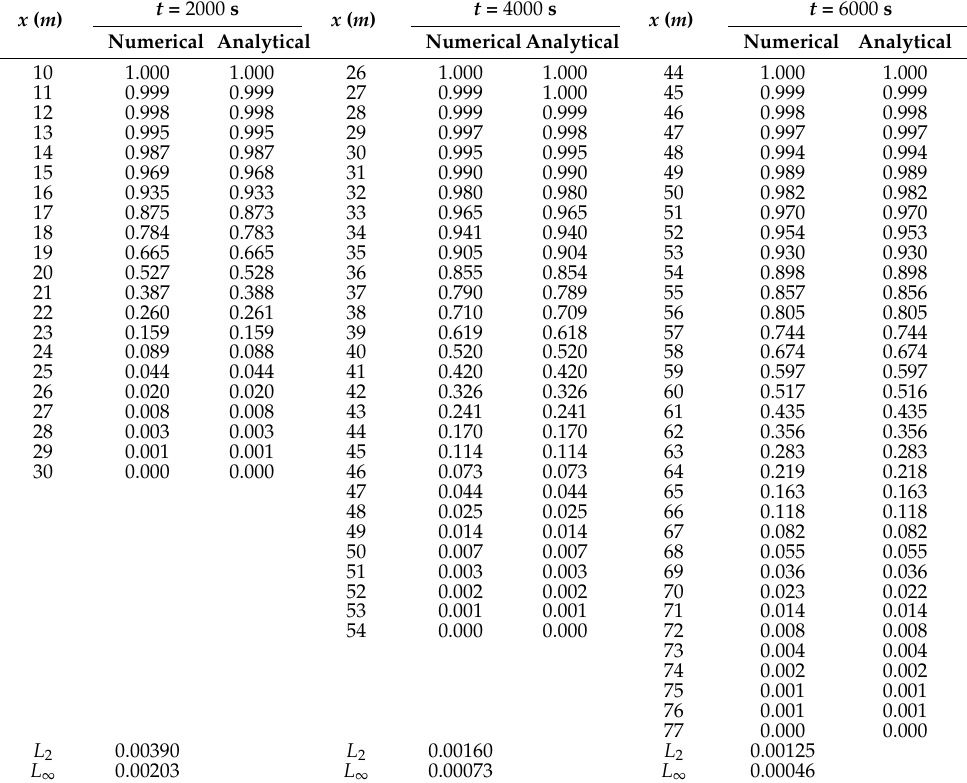
Table 3. Comparison of the analytical solution with the numerical results of the ERK4-NCCD scheme for the time step ∆ t = 1 s at times t = 2000 s, t = 4000 s, and t = 6000 s.